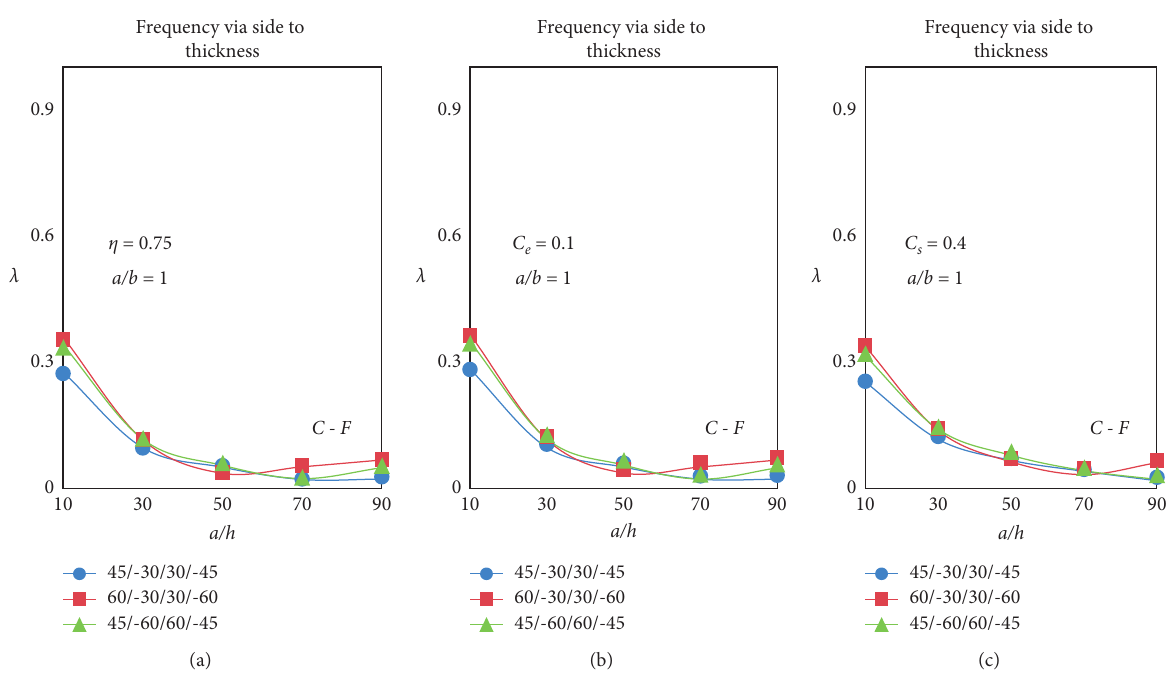
Figure 7: Influence of side-to-thickness ratio on frequency parameter value of 4-layered plates: